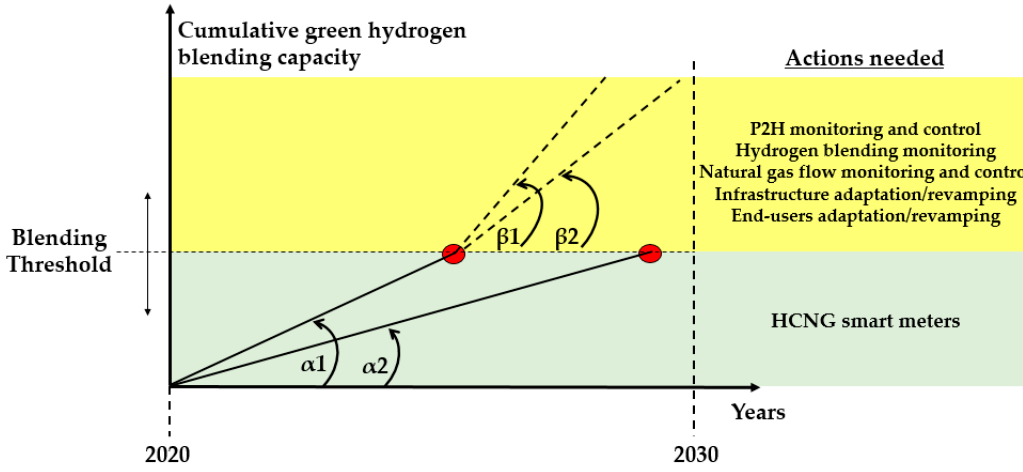
Table 2. Mean natural gas composition conveyed by the Italian natural gas networks [43].